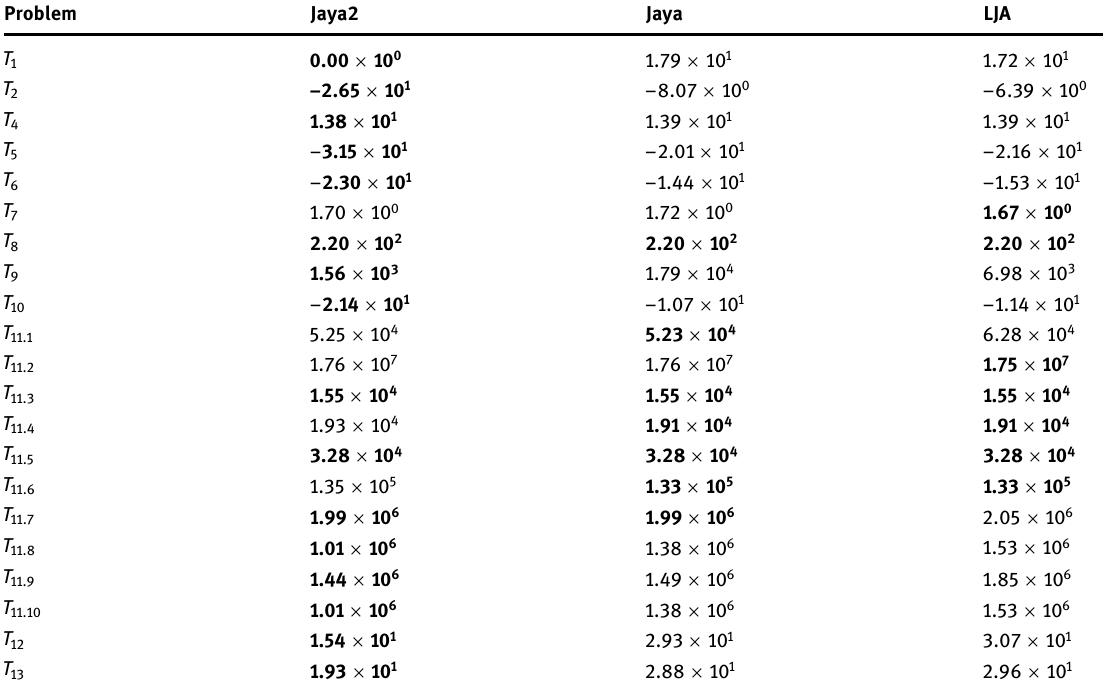
Table 7: The CEC 2011 median function values achieved by Jaya2, Jaya, and LJA over 25 runs and 150,000 function evaluations Problem